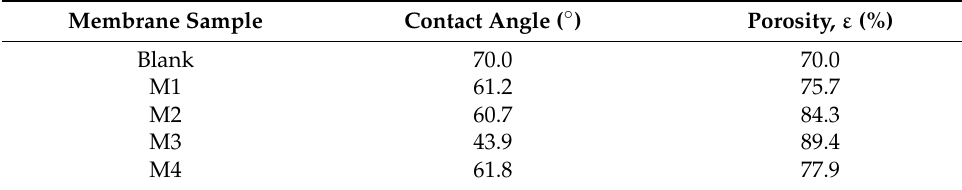
Table 5. Contact angle and porosity of the membrane